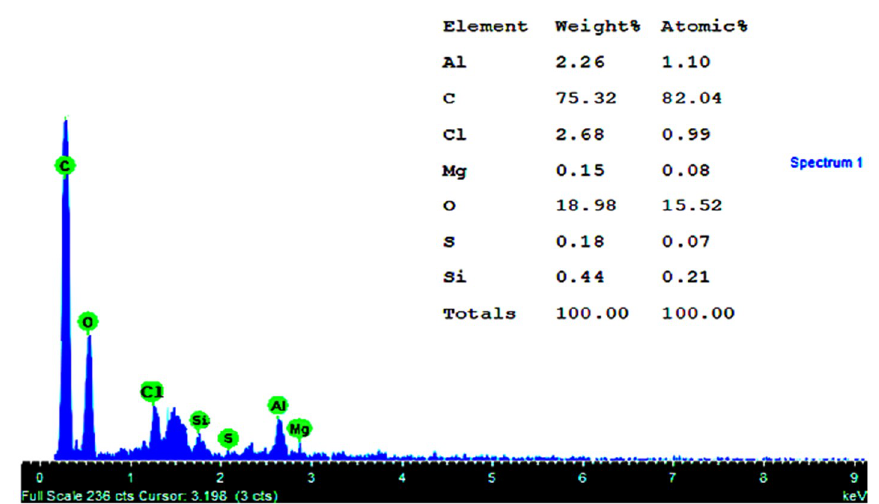
Figure 5. Atomic spectrum and quantification by scanning electron microscope and energy dispersive spectroscopy (SEM-EDS) equipment.